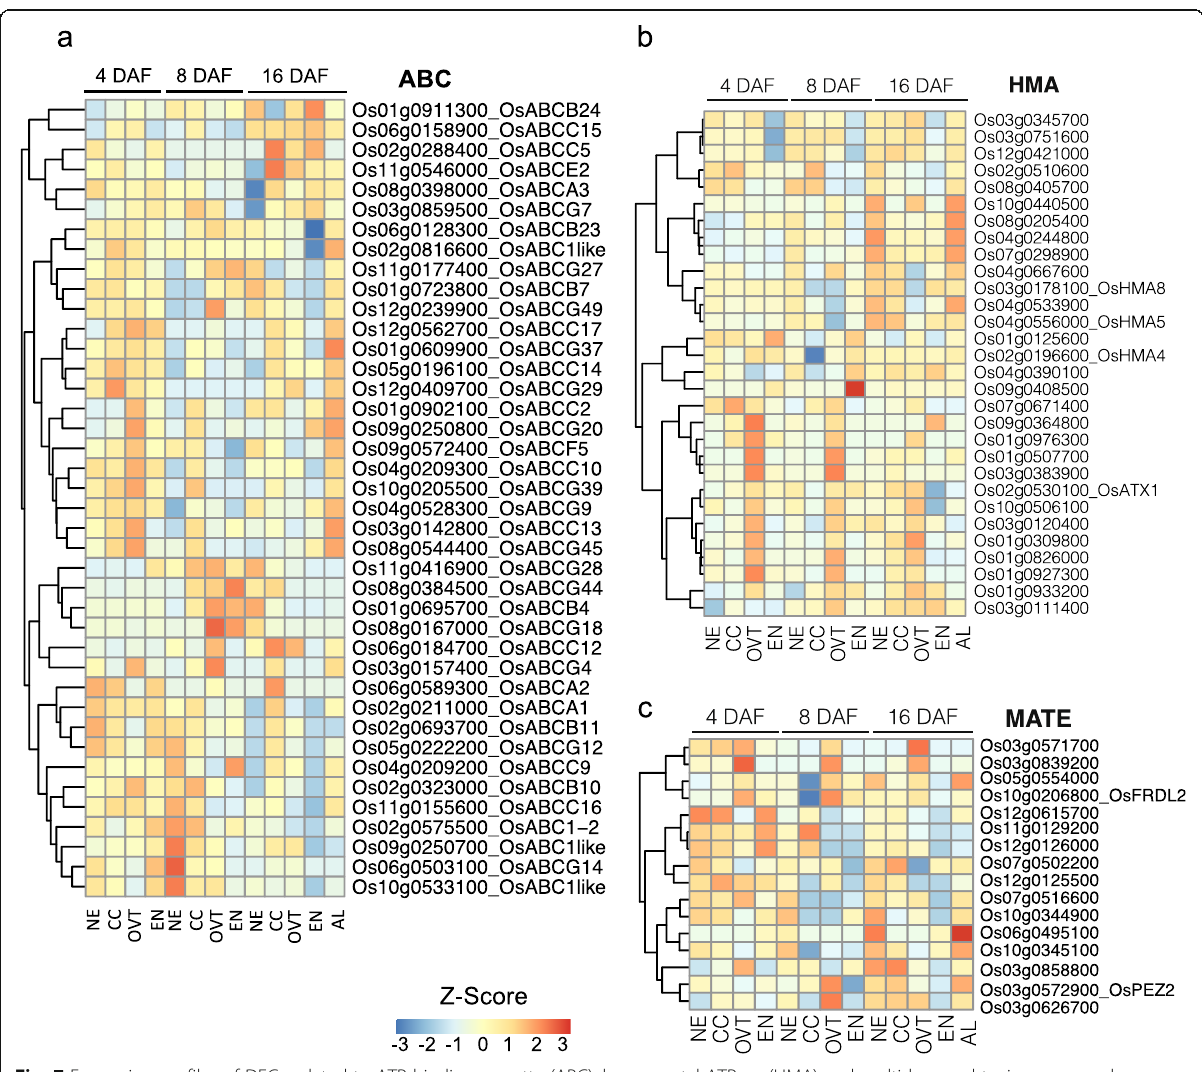
Fig. 7 Expression profiles of DEGs related to ATP-binding cassette (ABC), heavy metal ATPase (HMA) and multidrug and toxic compound extrusion (MATE) transporter families. a Expression pattern of genes from the ABC transporter family. b Expression pattern of genes from HMA transporter family. c Expression pattern of genes from MATE transporter family. The gene-normalized signal intensities are shown in the heat maps using Z-Scores. DAF: days after